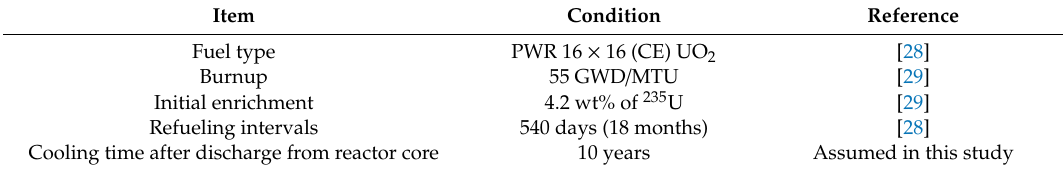
Table 2. Reference conditions of target SNF for neutron activation calculation in this study